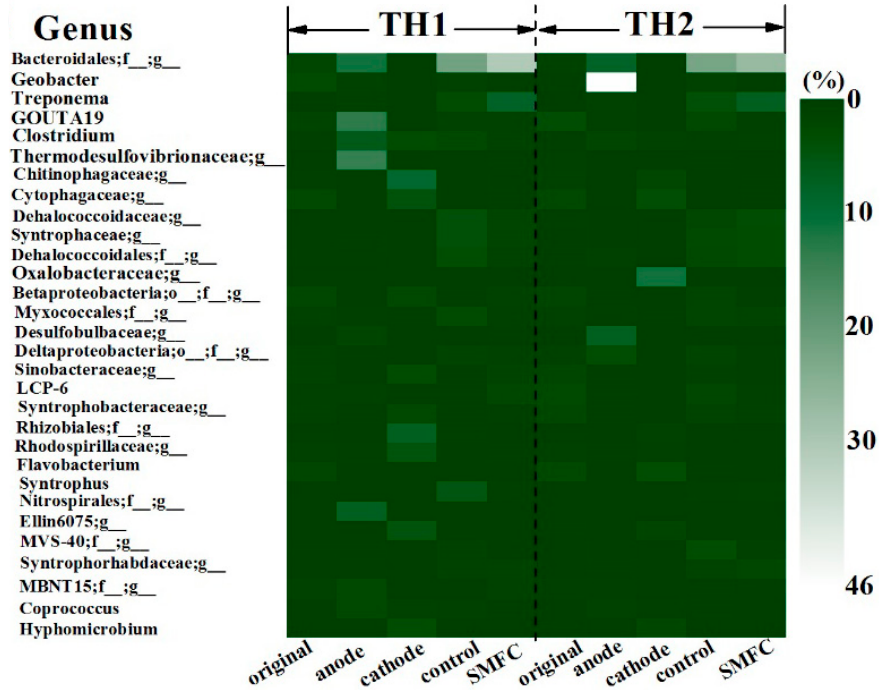
Figure 6. Relative abundance percentages of bacterial genus communities in original sediments, bulk sediments and electrode biofilm from the two sampling sites at the end of the experiments.